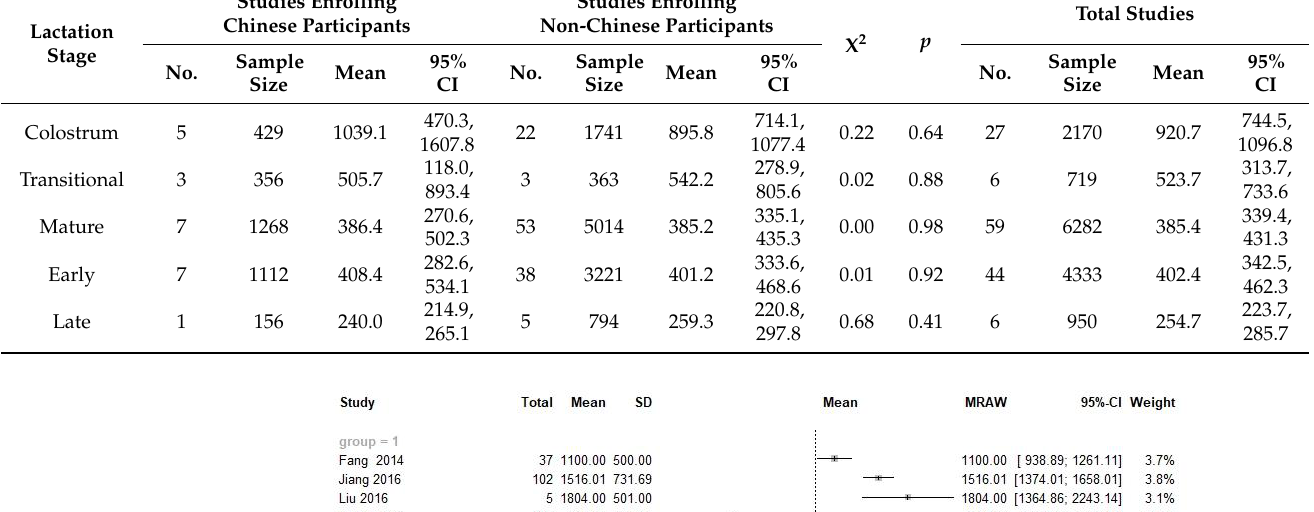
Table 2. Summary of findings for the comparison between Chinese and non-Chinese human milk samples.